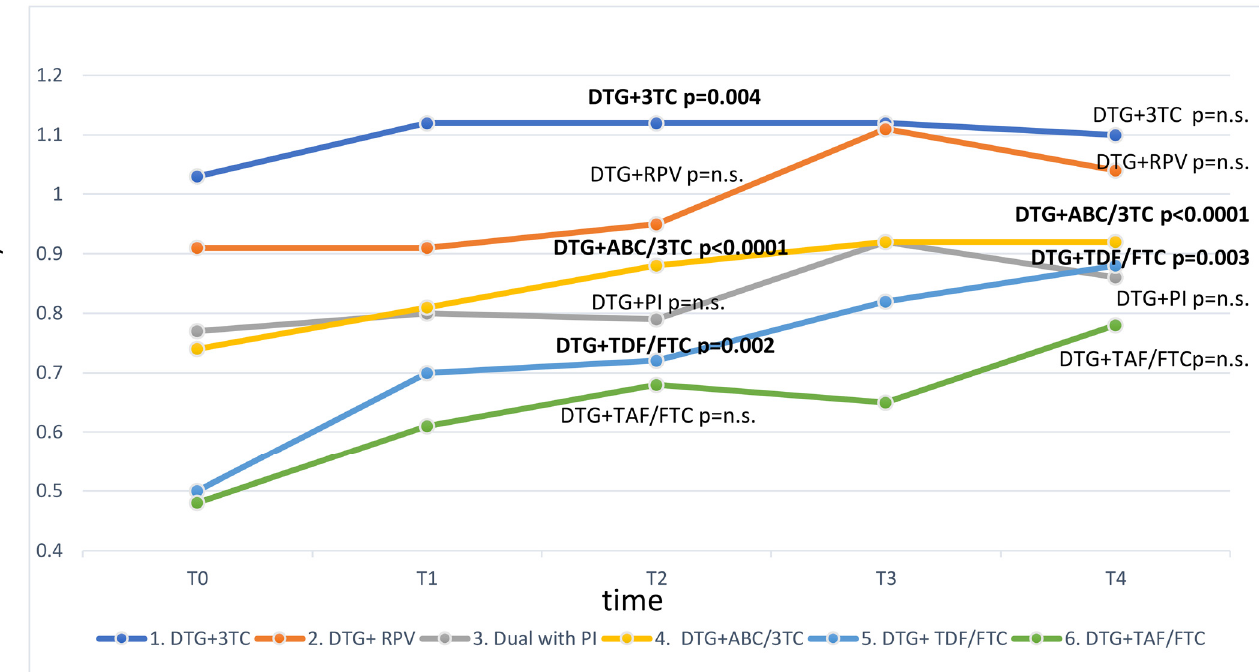
Figure 1. CD4 and CD8 T cells and CD4/CD8 ratio dynamics in patients in treatment with Dolutegravir. Values that significantly changed compared to baseline ( p < 0.05) are indicated in bold;